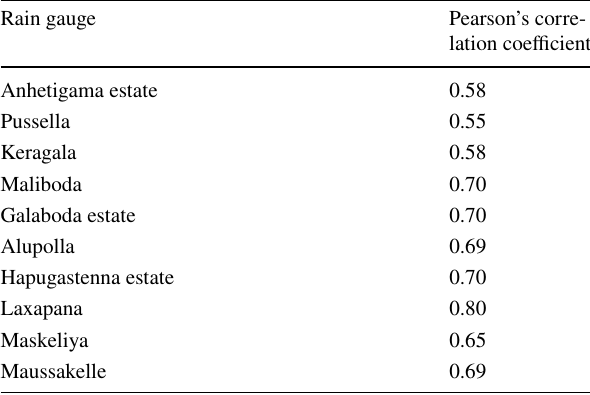
Fig. 6 Comparison of monthly power generation against the monthly rainfall Table 4 Pearson’s correlation coefficients of rainfall and power gen- eration time